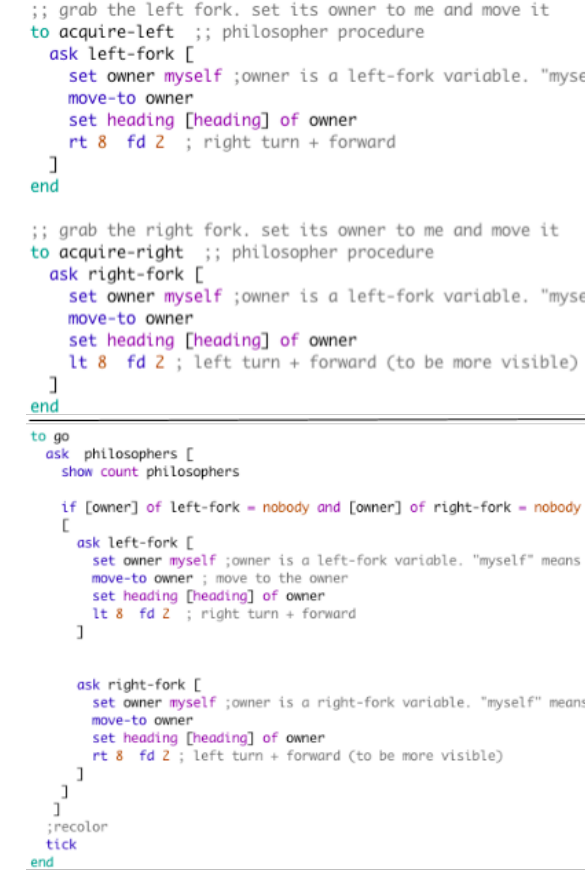
Fig. 4 Use of functions to represent the fork taking above; and less functions below, on NetLogo.